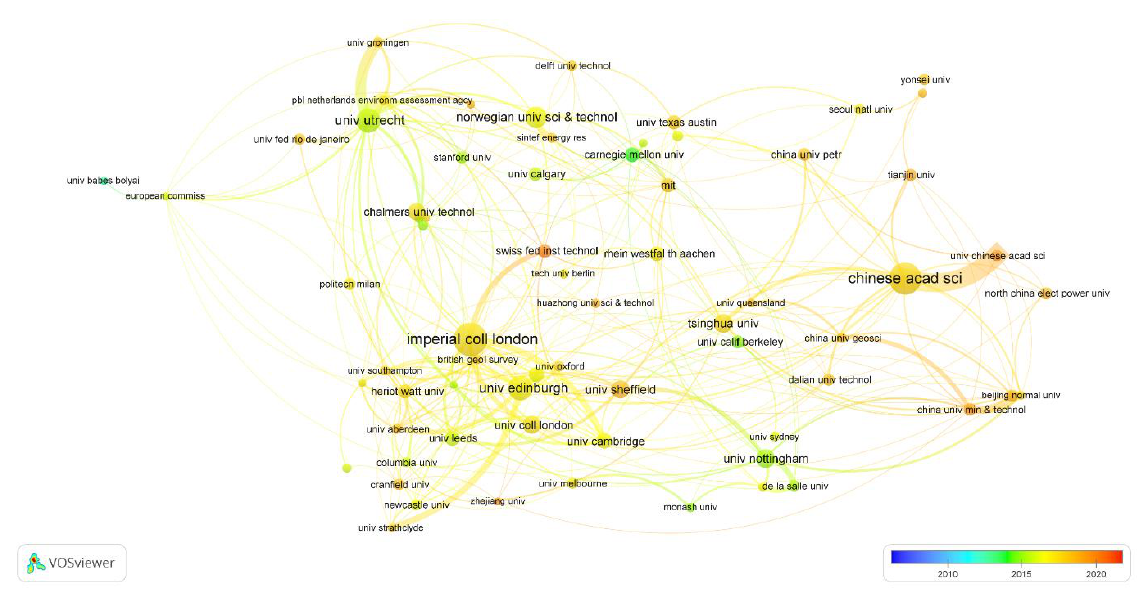
Figure 7. Network visualization map of research collaboration among institutions on carbon capture and utilization, with a minimum of 20 publications.